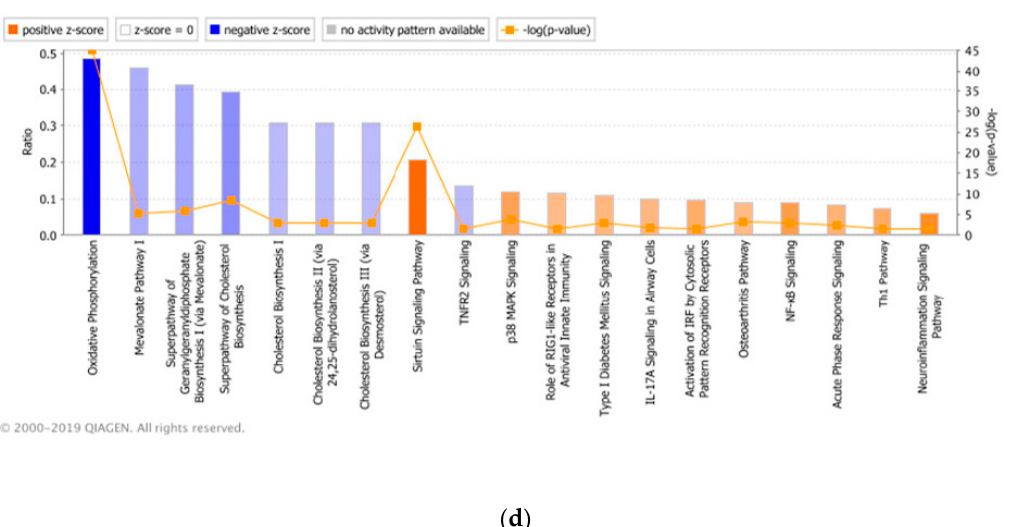
Figure 8. Significantly enriched canonical pathways through Ingenuity Pathway Analysis among differentially expressed genes by genetic line and treatment ( p < 0.05 and z > 0), where orange (positive z-score) refers to predicted of activation and blue (negative z-score) predicted of inhibition. ( a ) Canonical pathways predicted in the Leghorn line with AH treatment. ( b ) Canonical pathways predicted in the Leghorn line with CH&NDV treatment. ( c ) Canonical pathways predicted in the Fayoumi line with AH treatment. ( d ) Top 10 Canonical pathways predicted in the Fayoumi line with CH&NDV treatment.